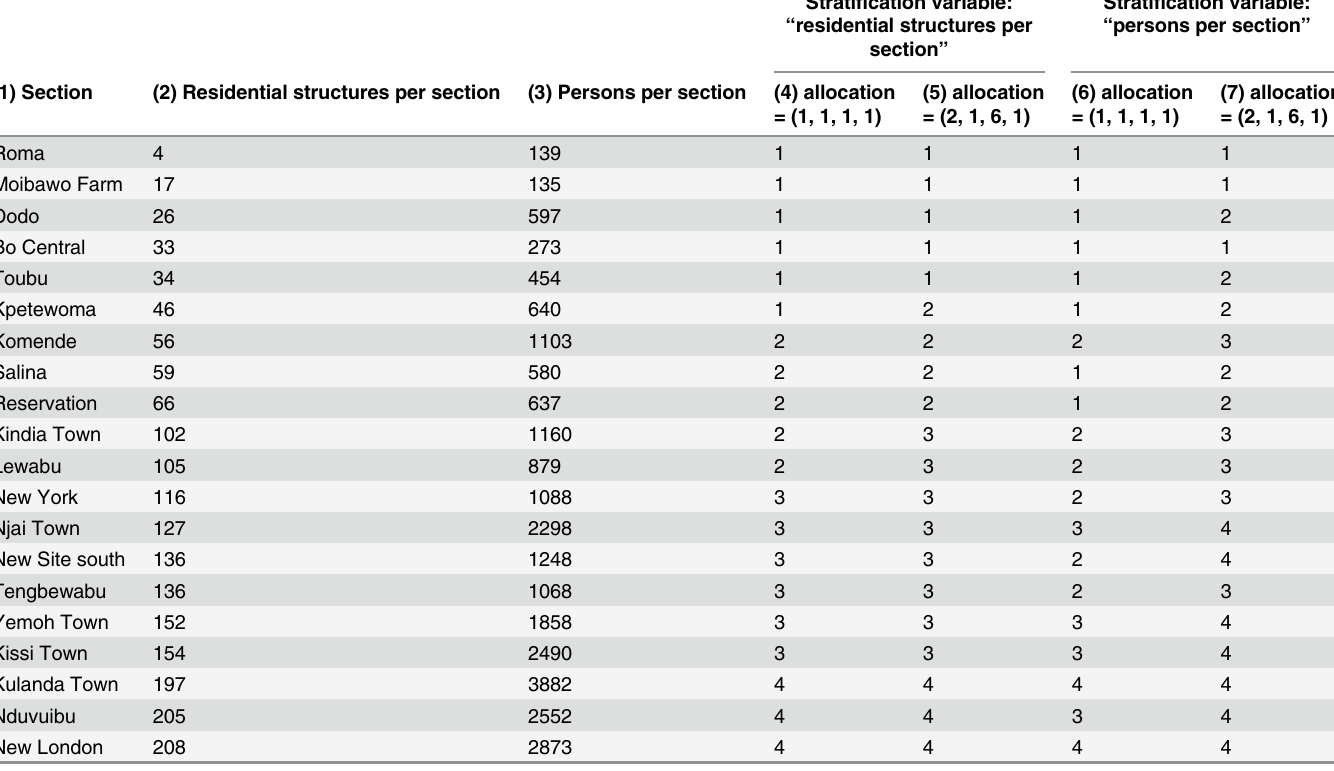
Table 4. Neyman stratification of Bo sections by “ residential structures per section ” and “ persons per section. ”